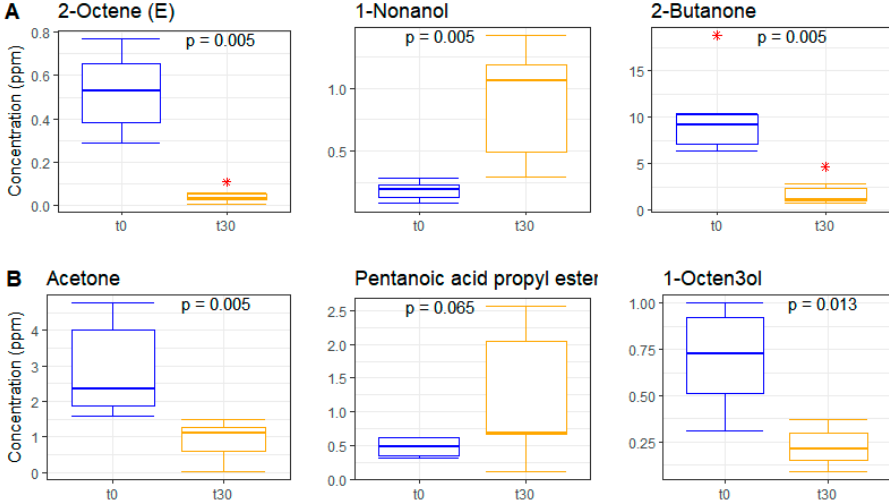
Figure 7. Boxplots showing the concentrations of the main fecal volatile molecules, analyzed by GC-MS, discriminating between t0 (blue) and t30 (orange) in the einkorn (EB; Figure 7 A ) and wheat (WB; Figure 7 B ) bread-based diet groups, as determined through Random Forest. *, outliers. p values were determined by Wilcoxon test.